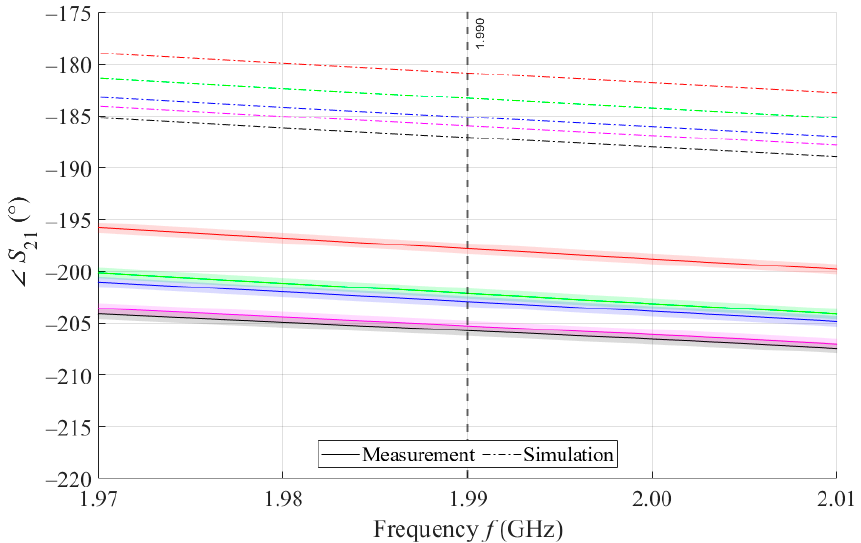
Figure 8. Detail of MSTL at 1.99 GHz and 4 mL.